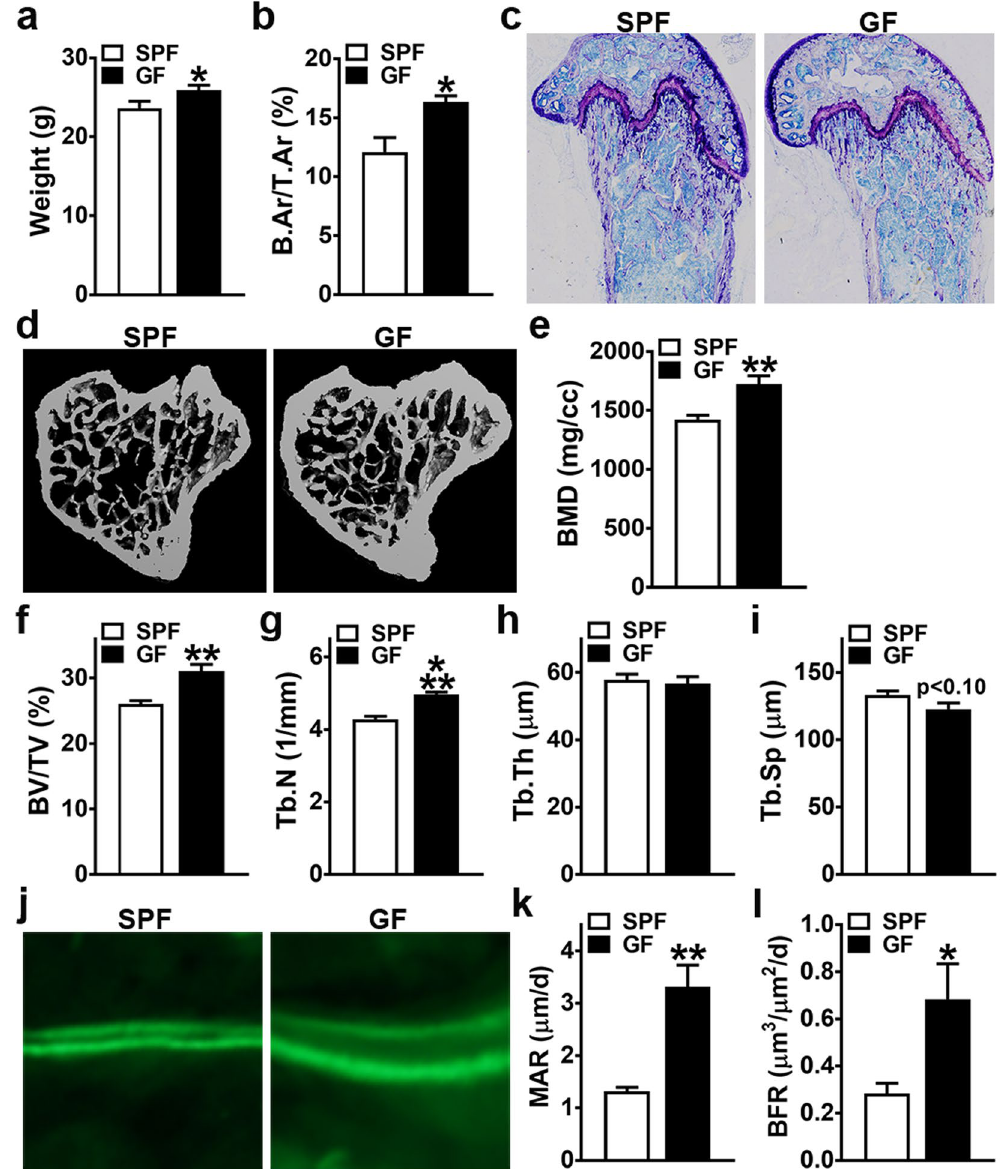
Figure 1. Animal weight and trabecular bone analysis. 11 to 12 week-old male SPF & GF mice were weighed; euthanized; femur harvested for histomorphometric analysis and tibia harvested for micro-CT analysis. ( a ) Animal weight (n = 12/gp). ( b , c ) Static histomorphometric analysis of distal femur trabecular bone area (n = 4/gp). ( b ) B.Ar/T.Ar = bone area. ( c ) Representative images (100 × ) of toluidine blue stained distal femur sections. ( d – i ) Micro-CT analysis of proximal tibia trabecular bone (n = 4/gp). ( d ) Representative reconstructed cross-sectional images, extending 360 µ m distally from where analysis was initiated. ( e ) BMD = trabecular bone mineral density. ( f ) BV/TV = trabecular bone volume fraction. ( g ) Tb.N = trabecular number. ( h ) Tb.Th = trabecular thickness. ( i ) Tb.Sp = trabecular separation. ( j – l ) Dynamic histomorphometric analysis of bone formation indices in distal femur trabecular bone; calcein administered 5 and 2 days prior to sacrifice (n = 4/gp). ( j ) Representative images of calcein labeled secondary spongiosa (400 × ). ( k ) MAR = mineral apposition rate. ( l ) BFR = bone formation rate. Data reported as mean ± SEM. * p < 0.05 vs. SPF; ** p < 0.01 vs. SPF; *** p < 0.001 vs